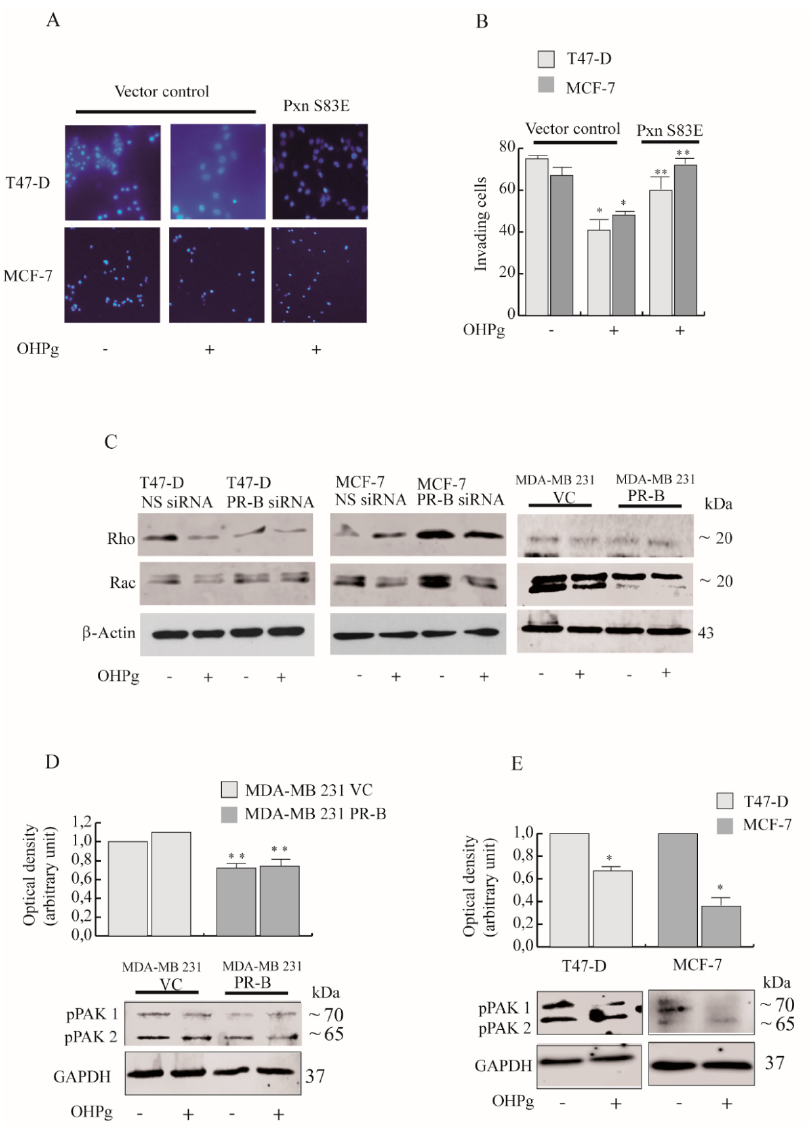
Figure 6. Phosphomimetic Pxn reverses the low invasive potential OHPg-treated cells. ( A ) Transmigration assay and ( B ) Invasion assay. Cells were co-transfected with a single phosphomimetic mutant of Pxn (Pxn S83E) or a vector control. Columns are the mean of three independent experiments each in triplicate; bars, SD; * p ≤ 0.05 vs. vehicle-treated cells. ** p ≤ 0.05 vs. OHPg-treated cells ( C ) Immunoblot analyses for Rho, Rac in T47-D, MCF-7 and in MDA-MB-231 cells transfected as indicated. β− Actin, loading control. Images show the results of one representative experiment out of three. ( D ) Immunoblot analyses for pPAK in MDA-MB-231 cells and in ( E ) T47-D, MCF-7 cells transfected as indicated. Columns are the mean of three independent experiments each in triplicate; bars, SD; * p ≤ 0.05 vs. vehicle-treated cells. ** p ≤ 0.05 vs. MDA-MB-231 VC vehicle-treated cells.